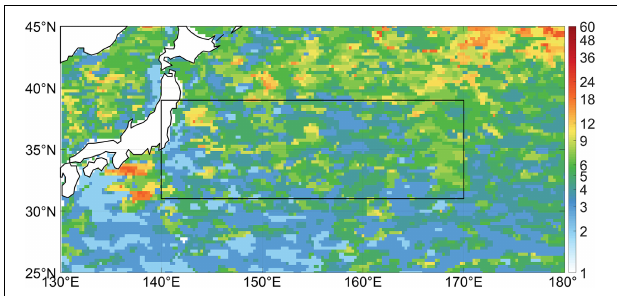
FIGURE 2 | Decorrelation timescale (month) of the eddy field extracted by the 5 ◦ × 5 ◦ spatial